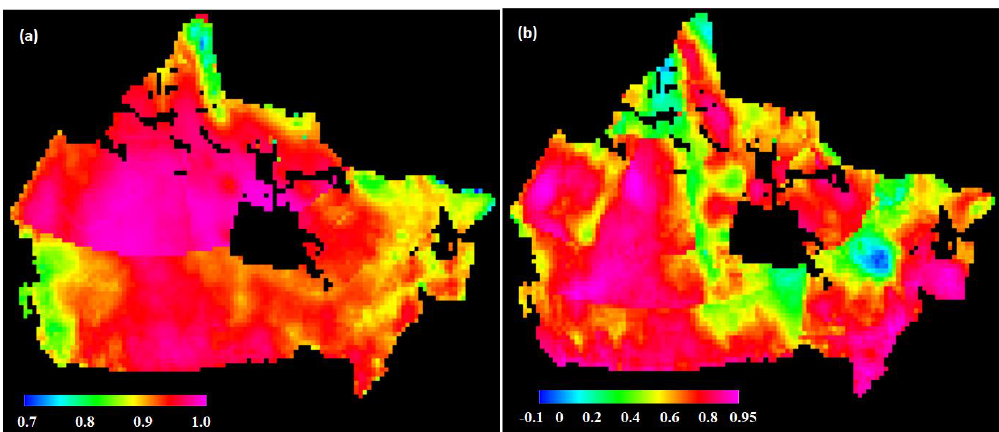
Figure 10. Correlation coefficients between the monthly anomalies of Met1km and the CANGRD dataset. The daily data from Met1km were converted to monthly anomalies corresponding to the grids of the CANGRD dataset. The large bars and the error bars are the averages and standard deviations of the 4890 grids of the CANGRD dataset.